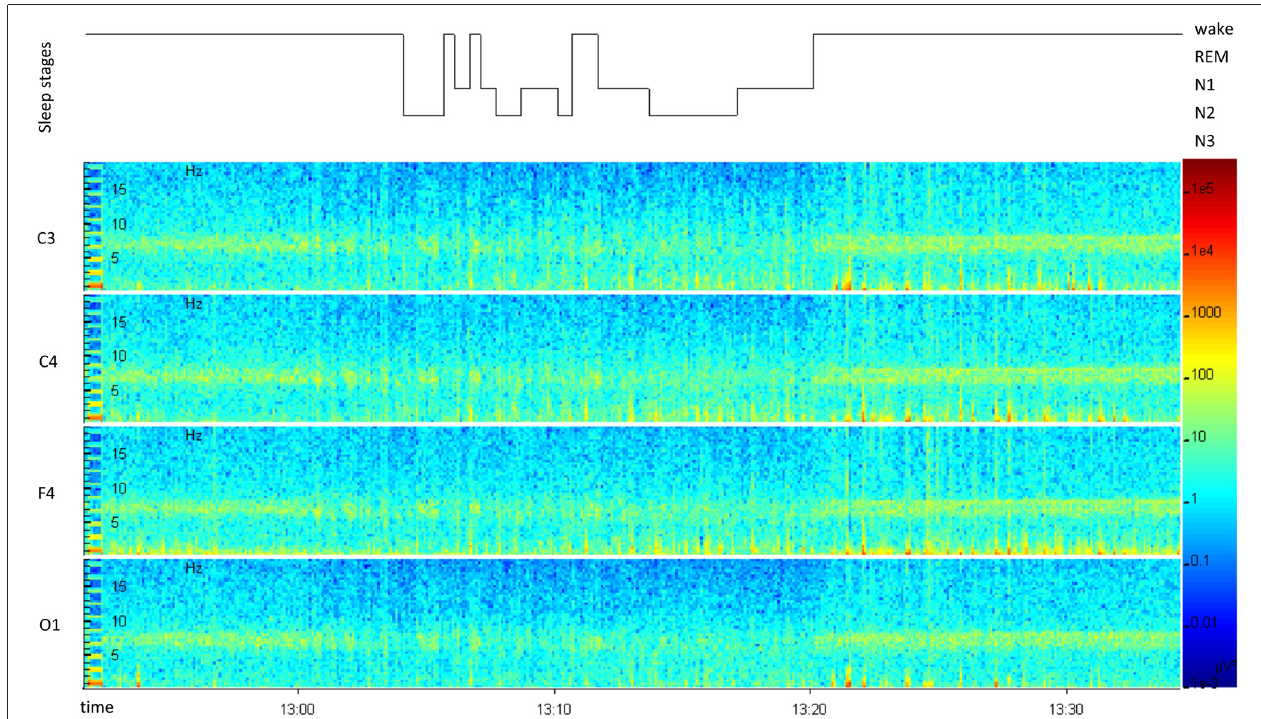
FIGURE 4 | Representative polysomnographic recording for daytime napping, from “lights off” until “lights on”. The hypnogram (top) displays the sleep stages over time. A spectral analysis of all recorded scull electrodes (C3, C4, F4, O1) is displayed